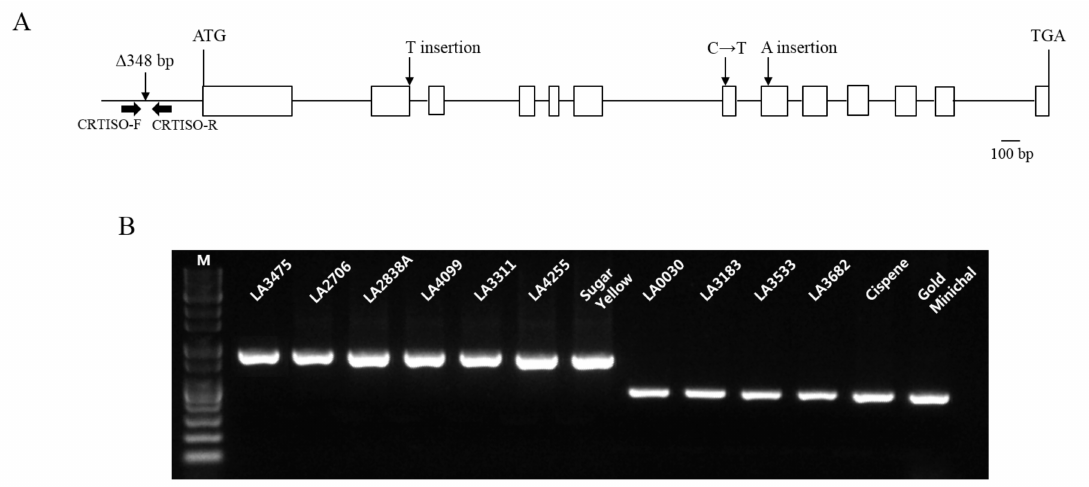
Figure 4. Gene structure of CRTISO and genotypic analysis of orange tomatoes enriched in prolycopene using the INDEL maker of CRTISO . ( A ) CRTISO mutation at the promoter region was previously identified [12] and three new mutations were identified in the coding region in this study. Two nonsense mutations were caused by one nucleotide insertion in the 2nd and 8th exons, respectively, and a missense mutation (C to T) was found in the 7th exon; ( B ) Deletion at the promoter region of CRTISO was distinguished by DNA marker (CRTISO) in prolycopene over-accumulated lines. Other tomatoes showing various colors, such as red (LA3475, LA2706, LA2838A), orange (LA4099, LA3311, LA4255), and yellow (Sugar Yellow) showed no deletion at the promoter region of CRTISO . M indicates 1 kb DNA